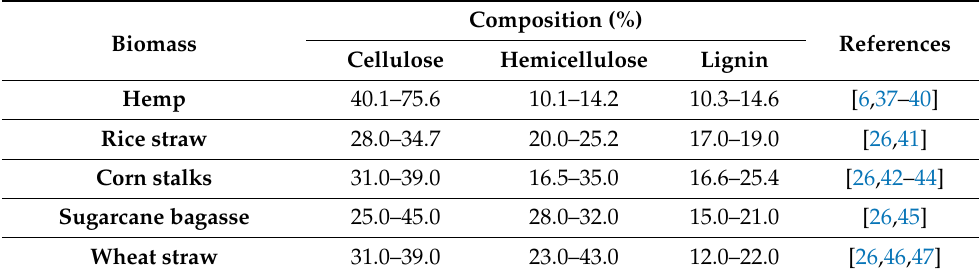
Table 1. Chemical composition of promising lignocellulosic biomasses.